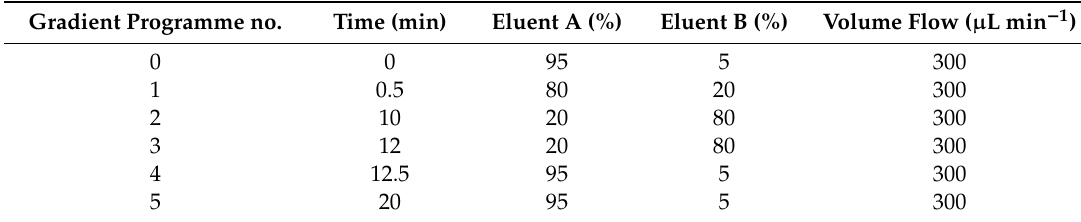
Table 1. LC-MS gradient elution programme. (The limit of detection (LOD) is 1.27 ng · L − 1 (for gabapentin) and 1.15 ng · L − 1 , (for diuron), respectively; the limit of quantification (LOQ) for both compounds is 10 ng · L − 1